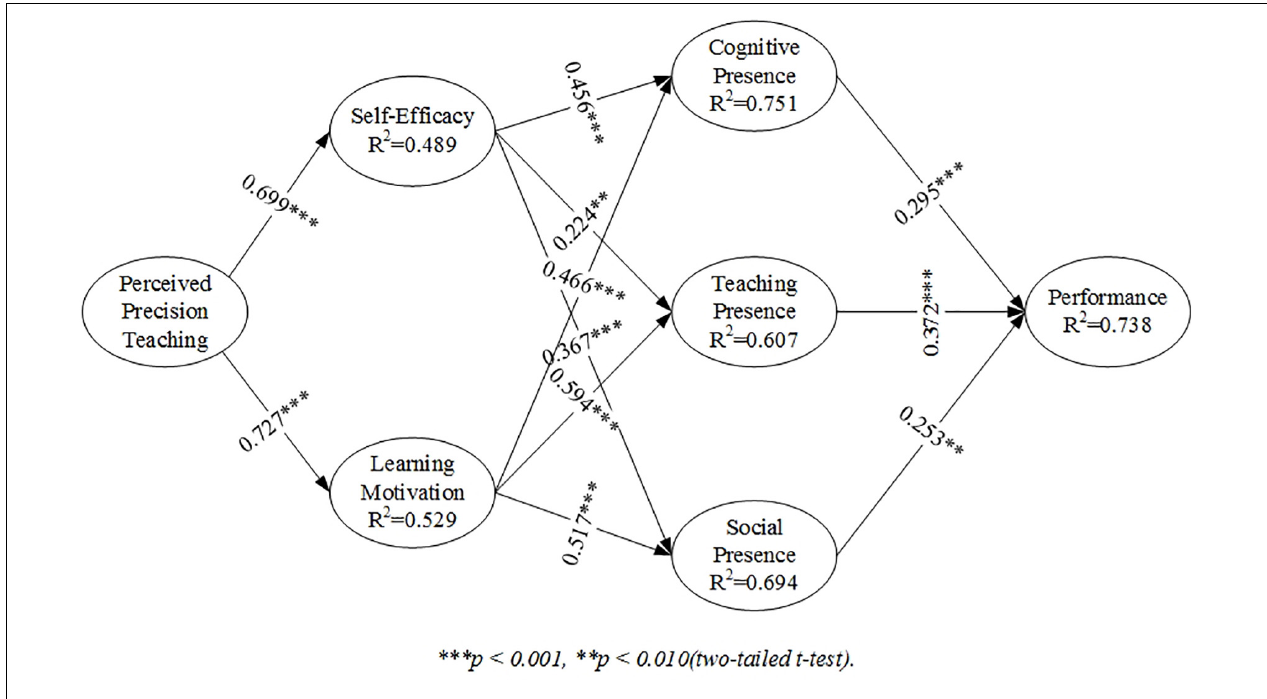
FIGURE 4 | PLS structural model.